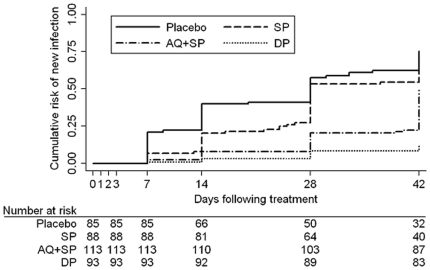
Cumulative risk of new infection in children free of malaria parasites at baseline over 42 days by treatment regimen.SP  =  sulfadoxine-pyrimethamine; AQ+SP  =  amodiaquine + sulfadoxine-pyrimethamine; DP  =  dihydroartemisinin-piperaquine.